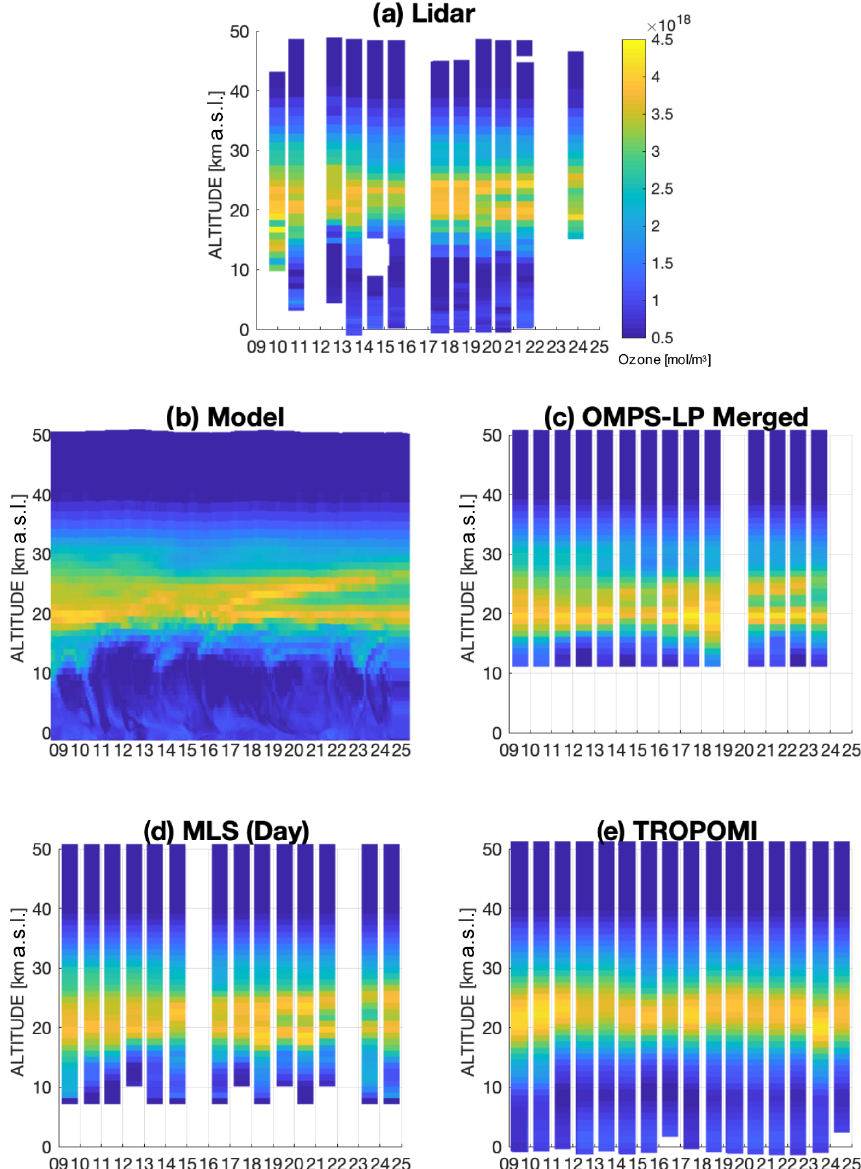
Figure 6. Ozone number densities across all platforms for the TROLIX-19 time period from the hybrid lidar data set (a) , GEOS-CF (b) , OMPS-LP (c) , MLS (d) and TROPOMI (e) . The x axis is the day of September